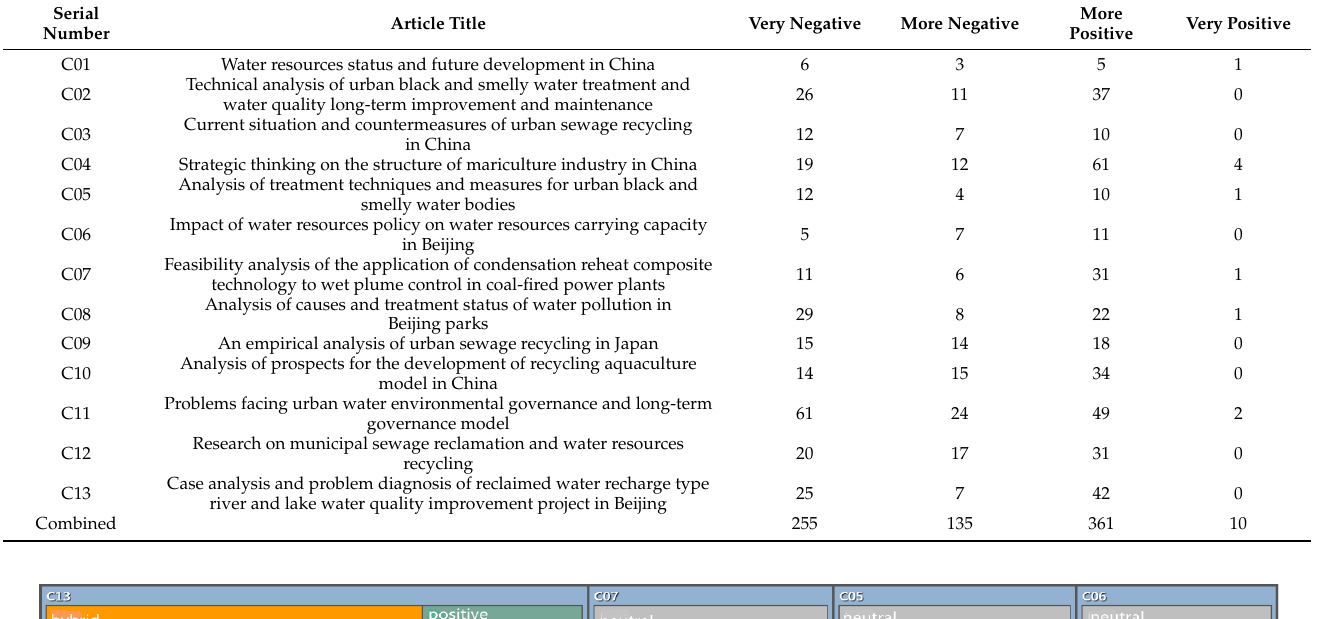
Table 10. Summary of results of sentimental analysis of highly cited literature in CNKI.